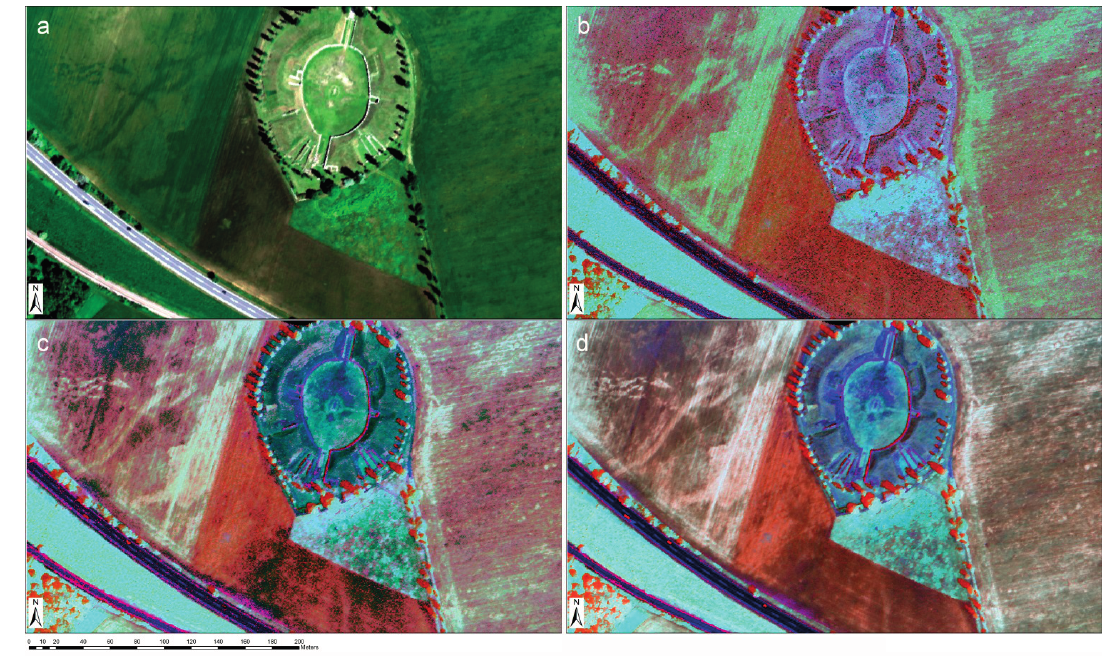
Figure 8. Illustration of the combined oversampling and REIP calculation offered by ARCTIS: ( a ) true color aerial photograph; ( b ) false color composite of REIP indices calculated between bands 50 (676 nm) and 63 (746 nm) using the original data; ( c ) REIP indices calculated from the smoothed data; and ( d ) from the smoothed data with ten additional ‘fictional’ bands leading to oversampled spectra. The three REIP indices in (b) to (d) are: wavelength position of maximum gradient (in red), maximum reflectance gradient (in green), and reflectance level for the wavelength of maximum gradient (in